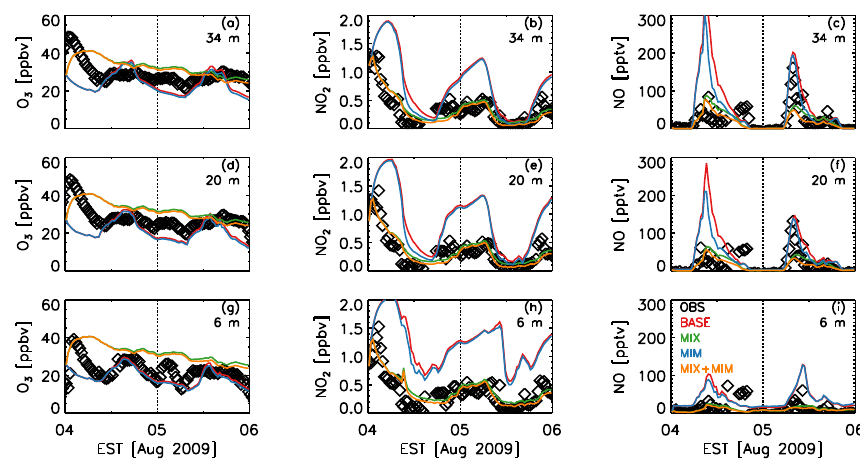
Fig. 5. Measured versus modeled time series for (a, d, g) O 3 , (b, e, h) NO 2 , and (c, f, i) NO at 34m, 20.4m, and 6m for the 4–5 August 2009 simulation period, showing observed concentrations (OBS, black) and modeled concentrations as follows: the original model configuration with modeled turbulence and RACM chemistry (BASE; red); the corrected mixing simulation with RACM chemistry (MIX; green); the original mixing scheme with RACM-MIM chemistry (blue; MIM); and the revised mixing scheme with RACM-MIM chemistry (MIX+MIM;